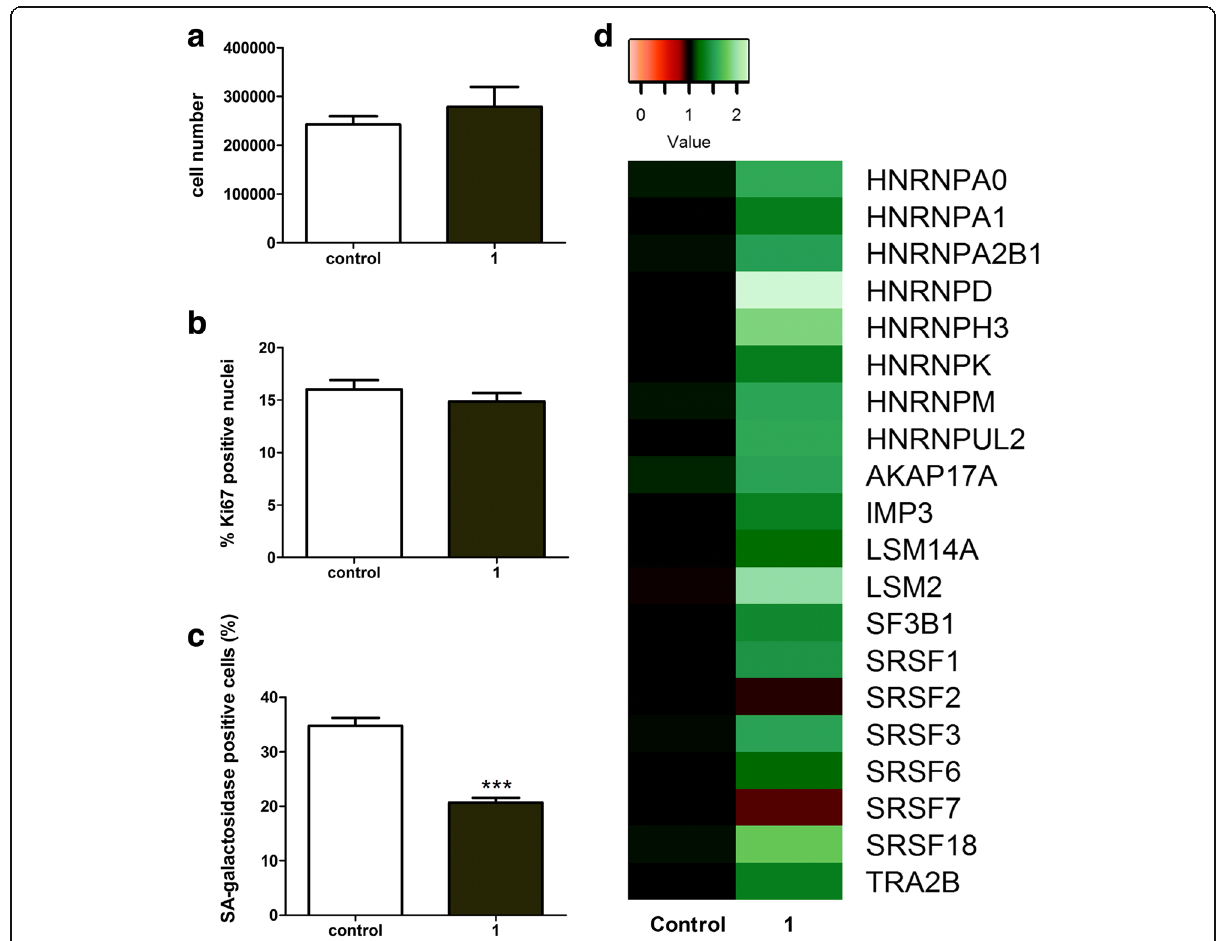
Fig. 6 Effects of resveratrol treatment in cells grown under serum starvation conditions. a Cell numbers of NHDF fibroblasts following